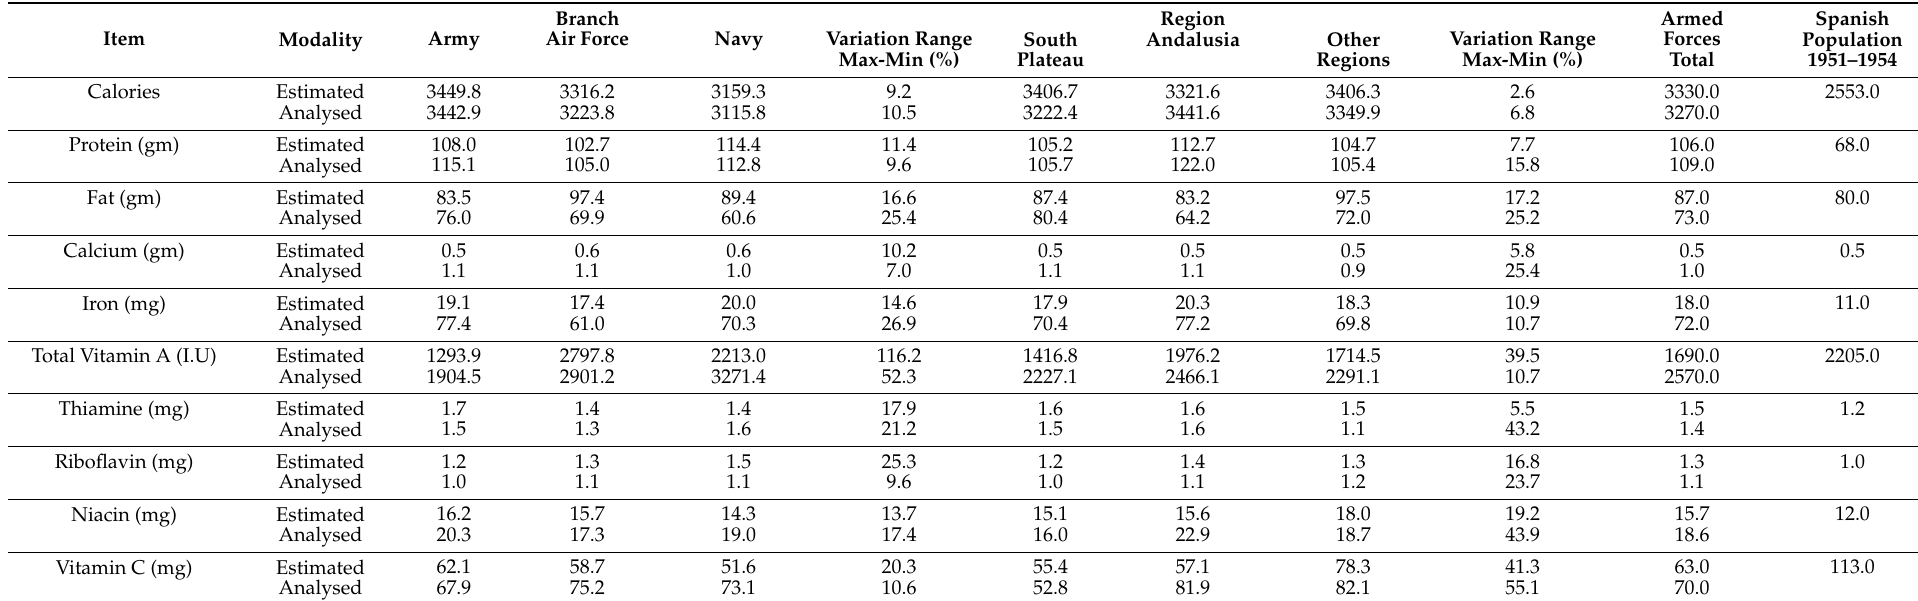
Table A3. Daily intake of nutrients in military canteens by branch and